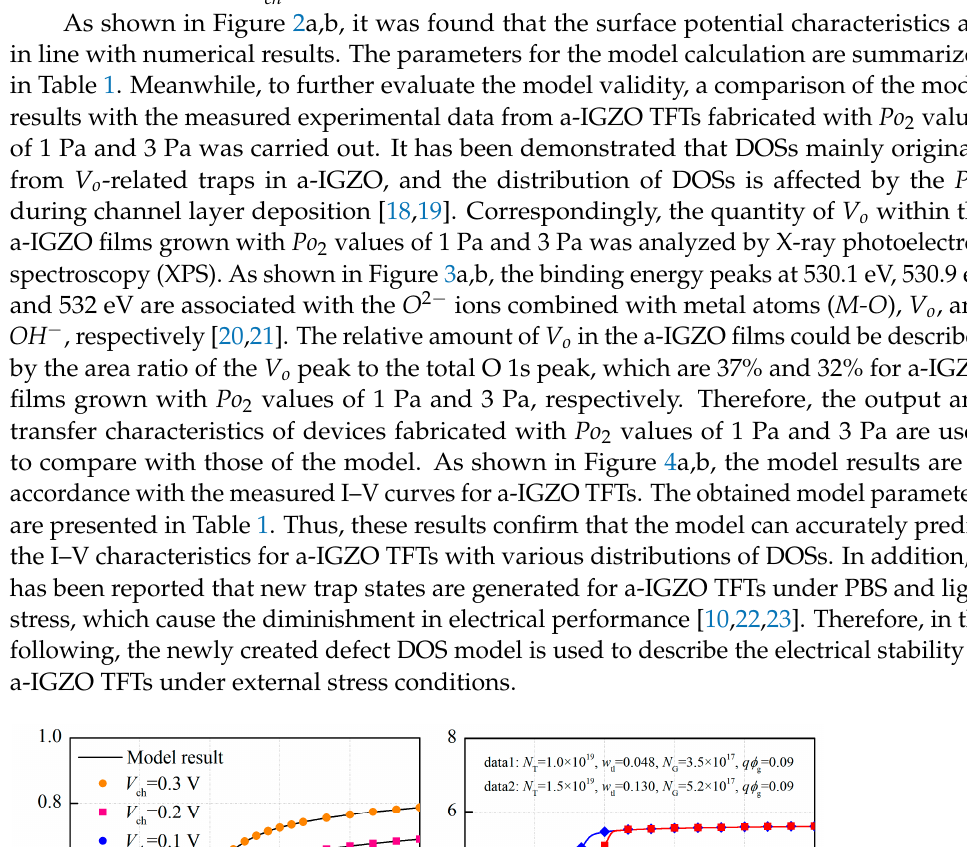
nm Figure 3. O 1s XPS spectra of a-IGZO thin films fabricated with Po 2 values of ( a ) 1 Pa and ( b ) 3 Pa.